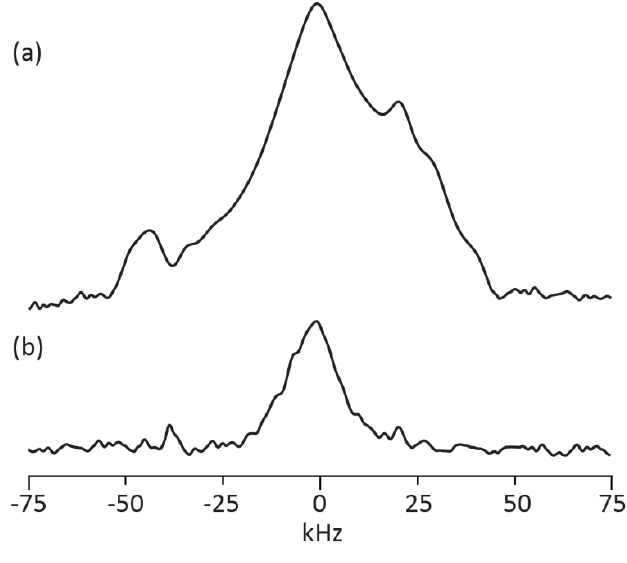
Figure 4. Example 1 H NMR spectra obtained with the single sided coil magnet for a 100 mL tomato paste sample without ( a ) and enclosed in ( b ) the aluminum lined tote